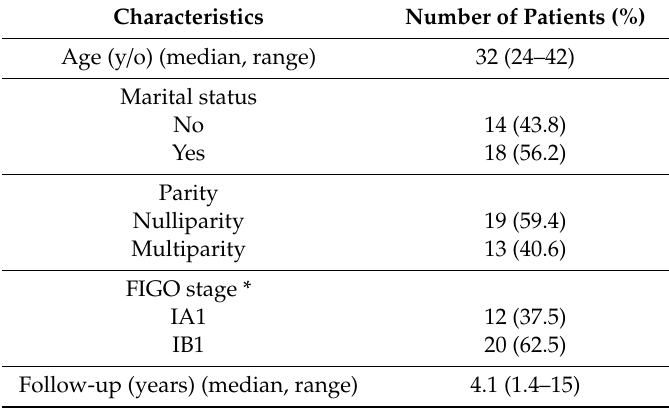
Table 1. Basic characteristics of 32 early-stage invasive cervical cancer patients treated with fertility-sparing